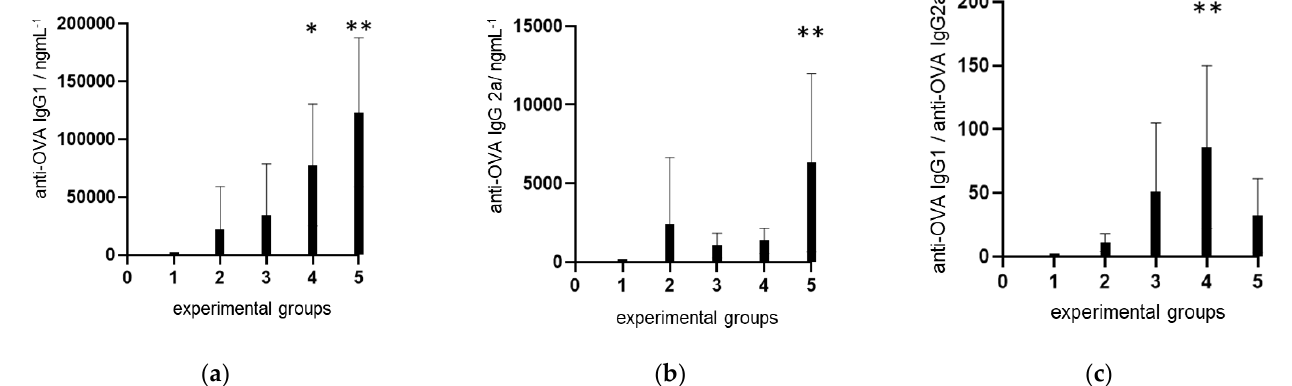
Figure 3. The effect of synthesized DMPs on the production of anti-OVA IgG subtypes: anti-OVA IgG1 ( a ), anti-OVA IgG2a ( b ), and IgG1/IgG2a ratio ( c ), in BALB/c mice immunized with OVA as an antigen. Experimental groups: 1—control group; 2—OVA alone; 3—OVA + ManAdDMP; 4—OVA + 8 ; 5—OVA + 14 . Bar graphs represent average values from individual mice from each group ( n = 5). * p < 0.05 and ** p < 0.01 denote statistical significance in comparison to the control group.